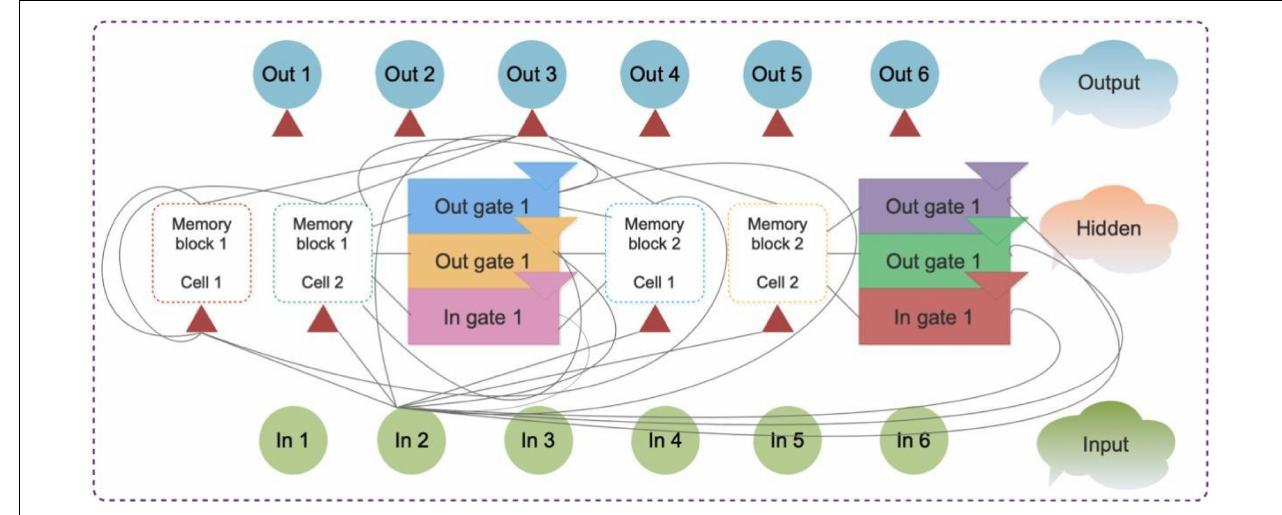
FIGURE 1 | Three-layer long short-term memory (LSTM) of two LSTM memory blocks (Gers et al.,